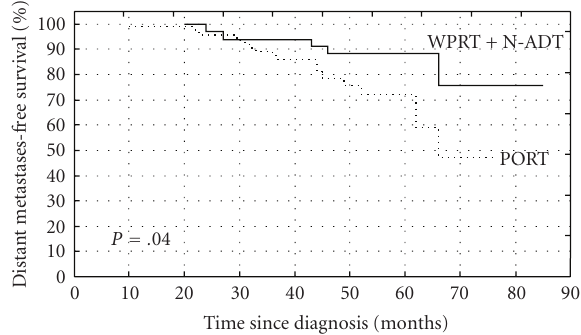
Figure 4: The Kaplan-Meier curves comparing distant metastases- free survival (DMFS) for patients at high-risk of nodal involvement, as defined in text receiving whole pelvic radiotherapy (WPRT) combined with neoadjuvant androgen deprivation therapy (N- ADT) or prostate radiotherapy only (PORT), ( P = .